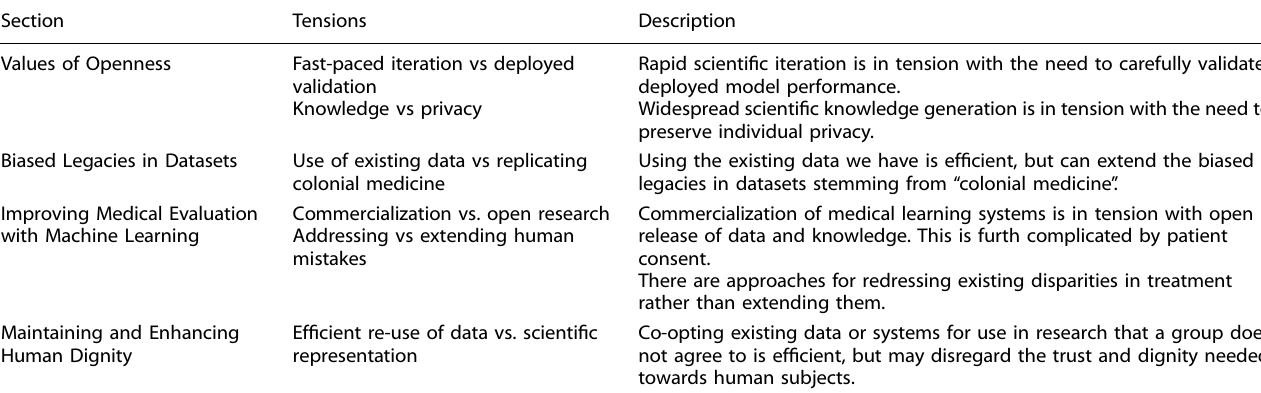
Table 1. Summarising the values, tensions and descriptions